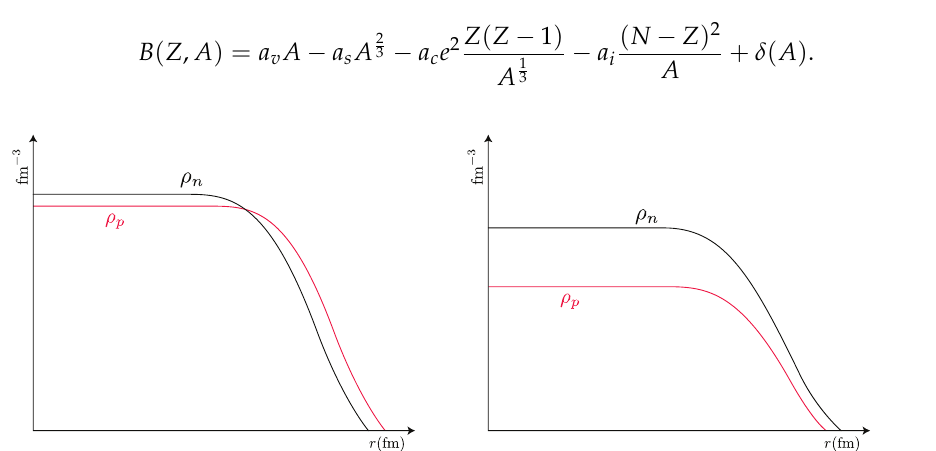
Figure 2. Schematic representation of the nuclear densities with equal number of protons and neutrons ( left ) and a larger number of neutrons than protons ( right ). The proton and neutron densities depend on the number of nucleons such that heavier elements present larger densities. Typical theoretical densities for 208 Pb are of the order of 0.09 fm − 3 for neutrons and 0.06–0.07 fm − 3 for protons [10].